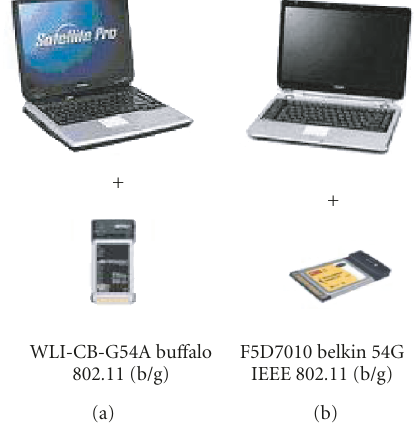
Figure 4: Loss patterns generation platform.